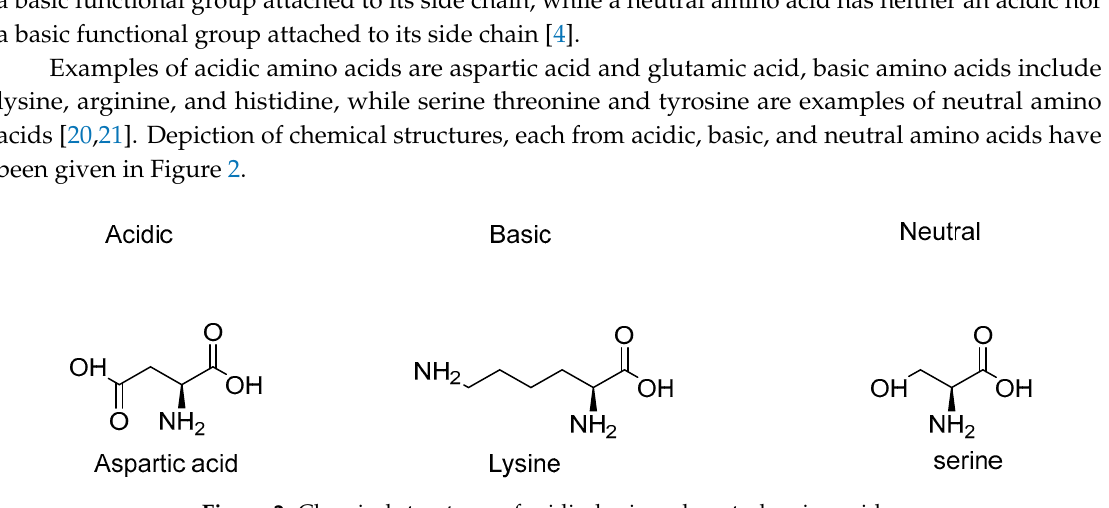
Figure 2. Chemical structures of acidic, basic and neutral amino acids.